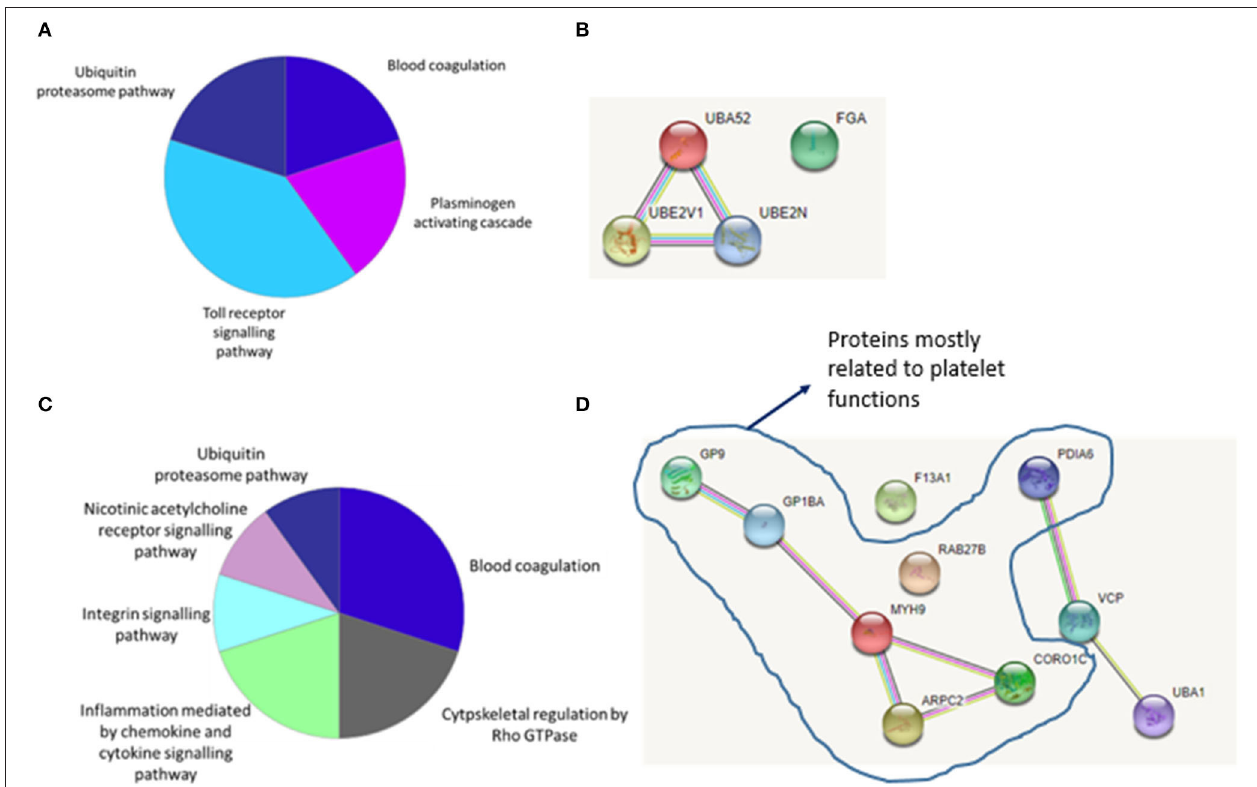
FIGURE 3 | (A) Biological pathways and interaction patterns associated with LAA specific proteins. Figure depicts a summary of the biological pathways associated with the specific protein groups identified as having an increased abundance in LAA samples. (B) Bioinformatic analysis of the statistically significant proteins using the STRING database identified the interaction patterns with known and predicted protein associations including physical and indirect functional protein linkages. (C) Biological pathways and interaction patterns associated with CE specific proteins. Figure depicts a summary of the biological pathways associated with the specific protein groups identified as having an increased abundance in CE samples. (D) Bioinformatic analysis of the statistically significant proteins using the STRING database identified the interaction patterns with known and predicted protein associations including physical and indirect functional protein